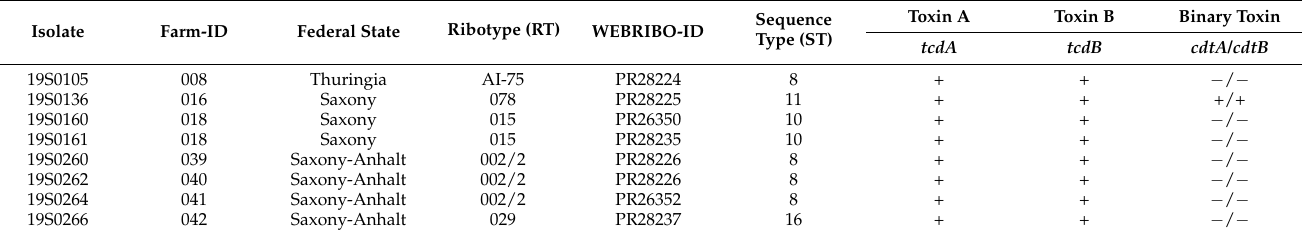
Table 1. Origin and molecular characteristics of isolates found in South American camelids